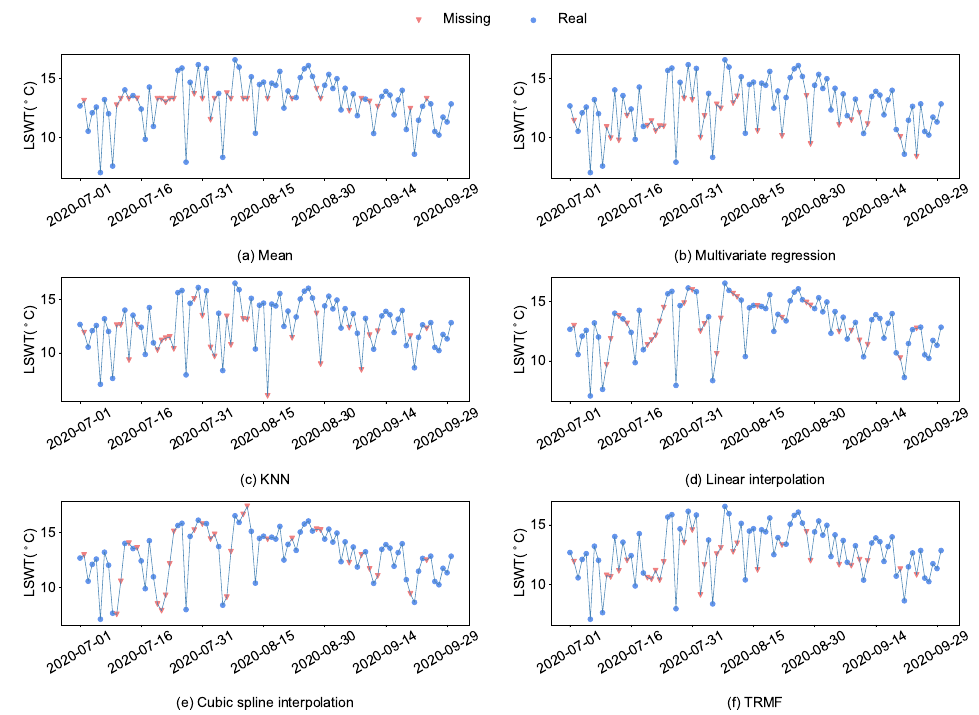
Figure 4. The filling effect samples of six missing value imputation methods. The data displayed are the surface water temperature of Qinghai Lake in the summer of